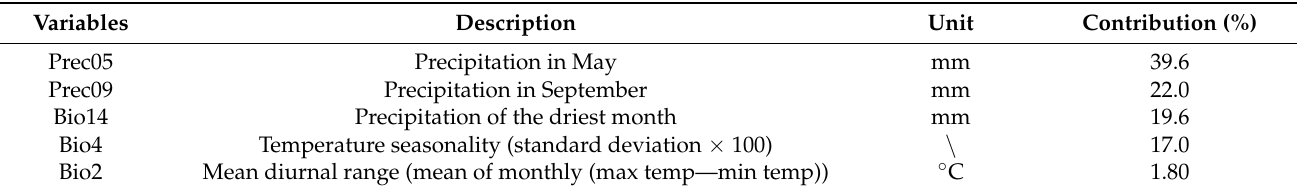
Table 1. The high contributing environmental variables of the potential suitable area of Ixodes scapularis .